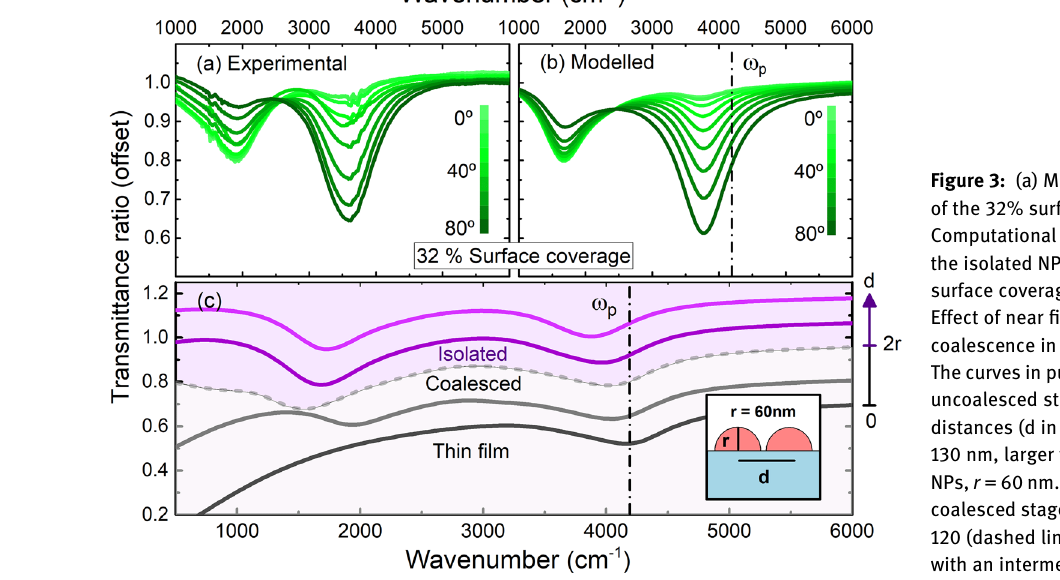
angle of incidence of 45 ° , within the NP the LE and HE